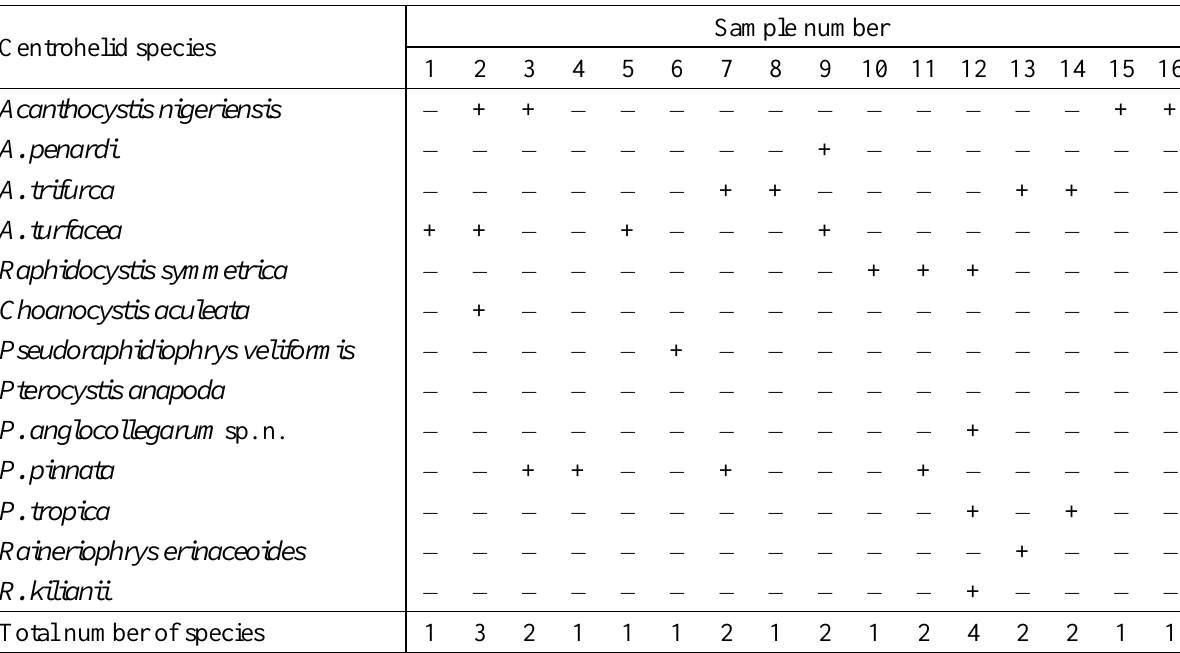
Table 2. Species diversity of centrohelid heliozoans in the studied mire biotopes. Samples numbers correspond with Table